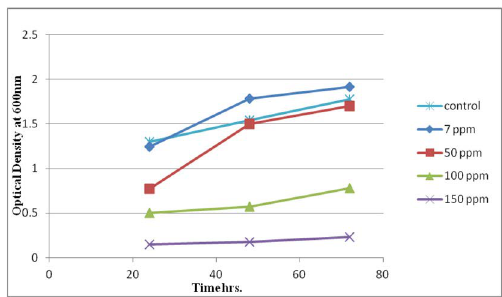
Fig. 8. Growth curve of isolate ST with (PbNO different concentrations.